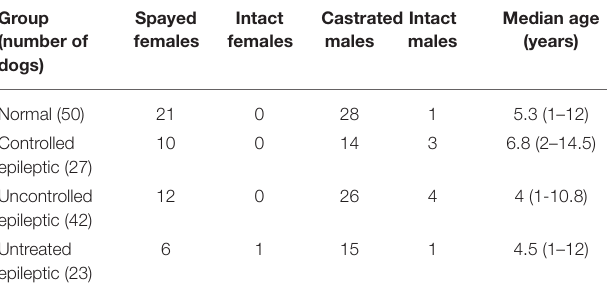
TABLE 1 | Patient demographics by group.